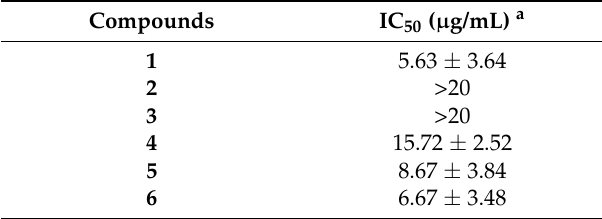
Table 4. Inhibitory effect of compounds 1 – 9 on overproduction of nitric oxide in lipopolysaccharide (LPS)-stimulated RAW 264.7